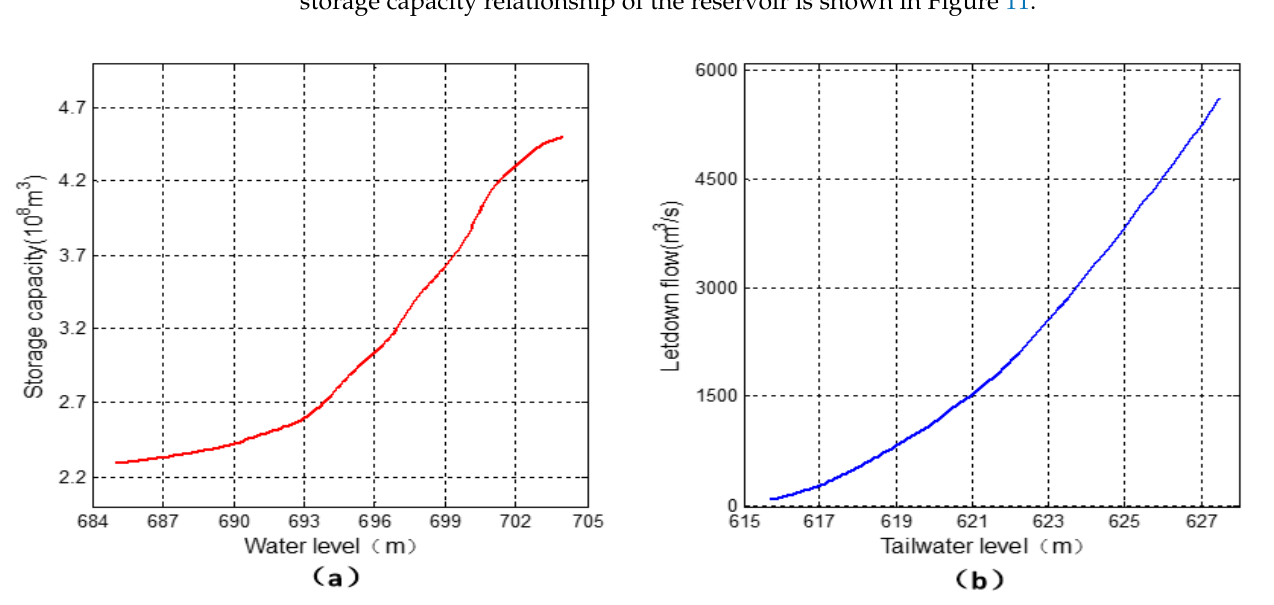
Figure 11. Characteristic curve of the hydropower station: ( a ) reservoir water level — storage capacity and ( b ) downstream water level — discharge flow.